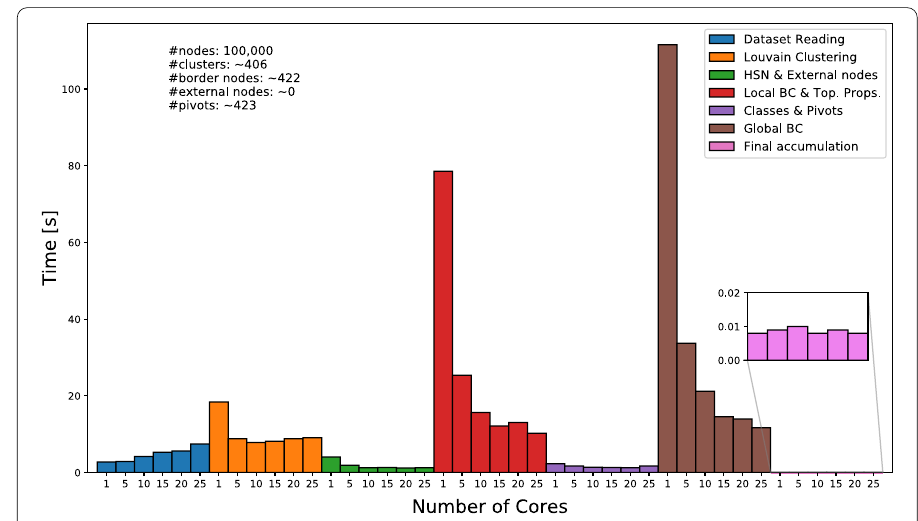
Fig. 13 Breakdown analysis of computation time on synthetic graph with 100,000 nodes